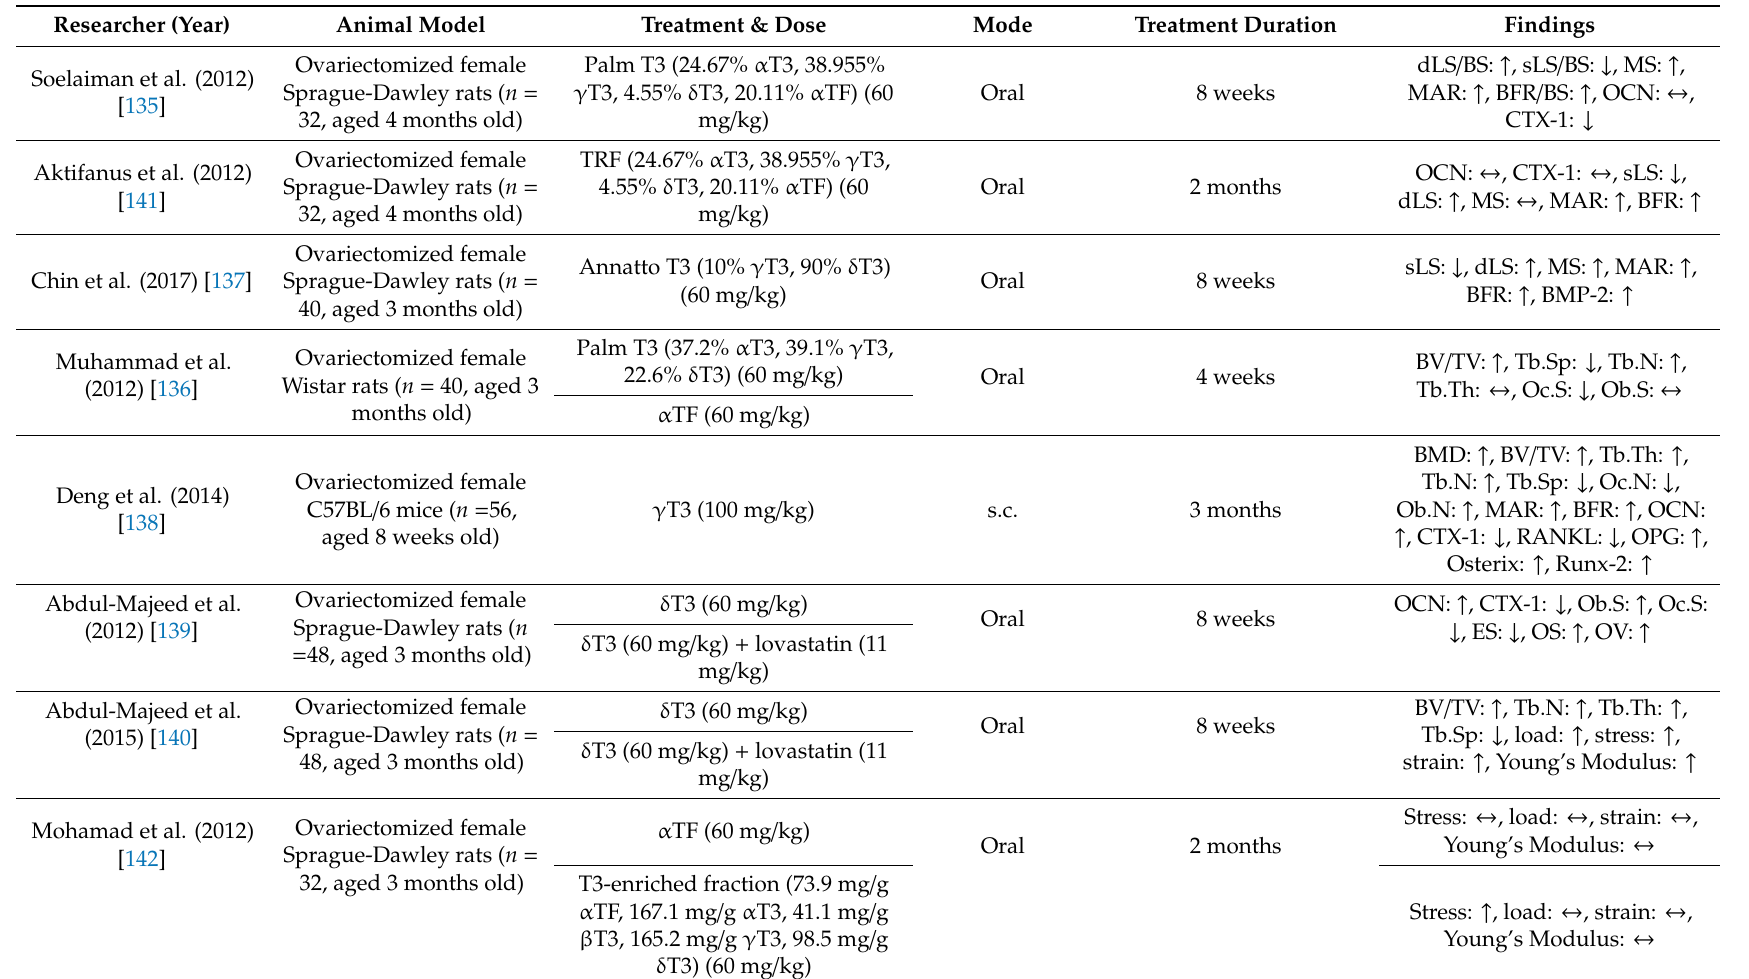
Table 7. E ff ects of T3 on osteoporosis in female